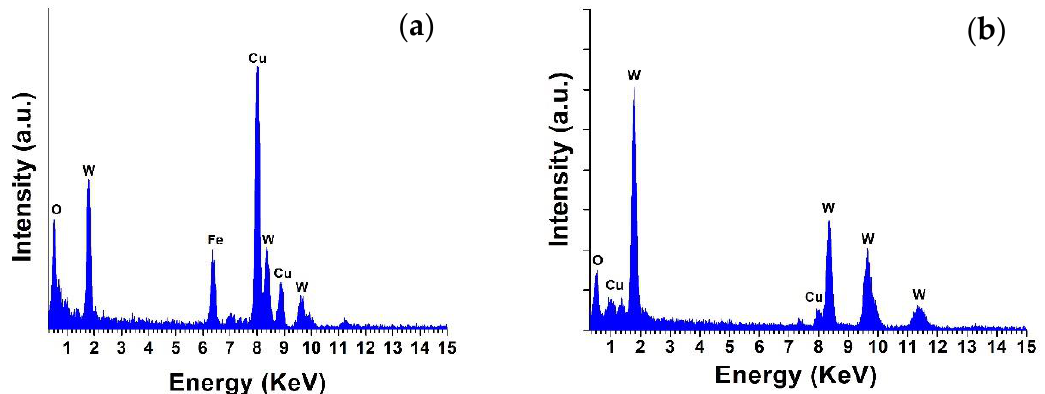
Figure 2. EDS spectra of WO 3 NW@Fe 2 O 3 ( a ) and WO 3 NW@CuO ( b ) nanocomposites.